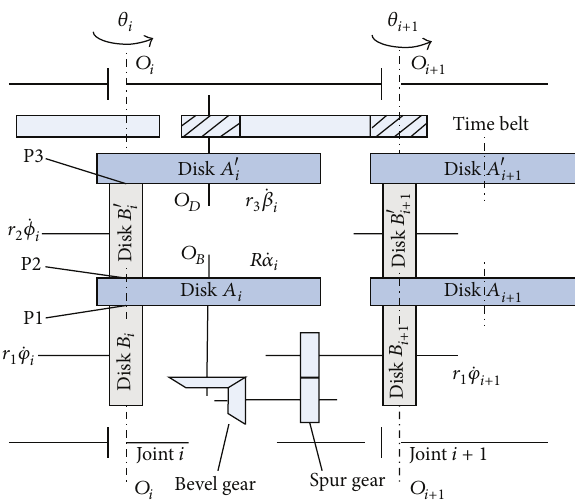
Figure 3: Structure diagram of joint 𝑖 mechanical